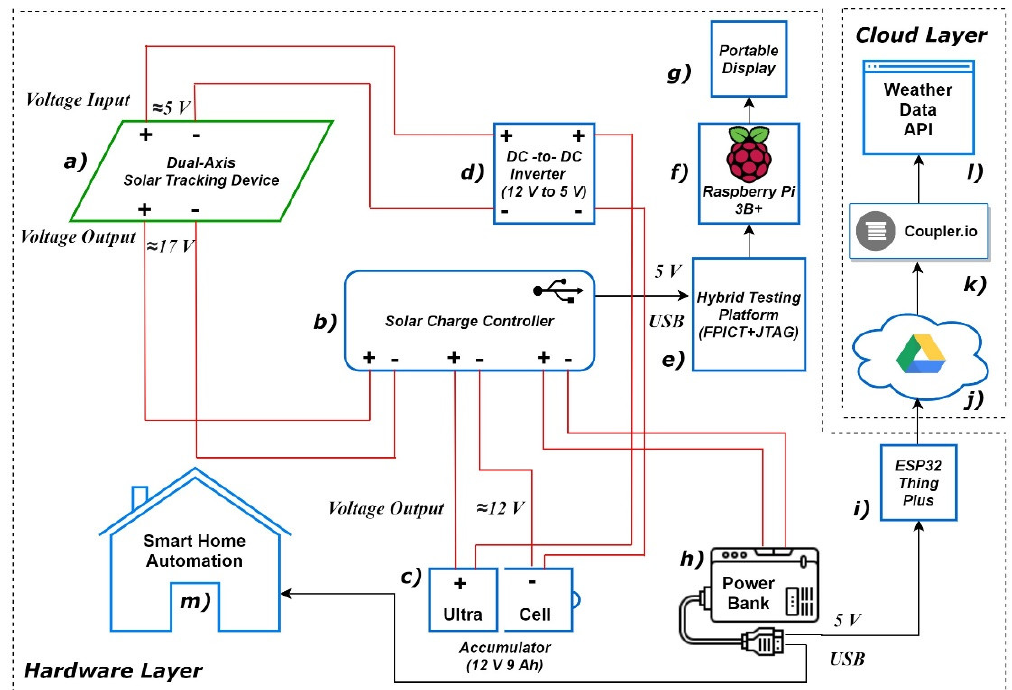
Figure 3. Conceptual Diagram of the Proposed Solar-Powered Smart Home Automation System with integrated Cloud Platform and Testing Facilities.